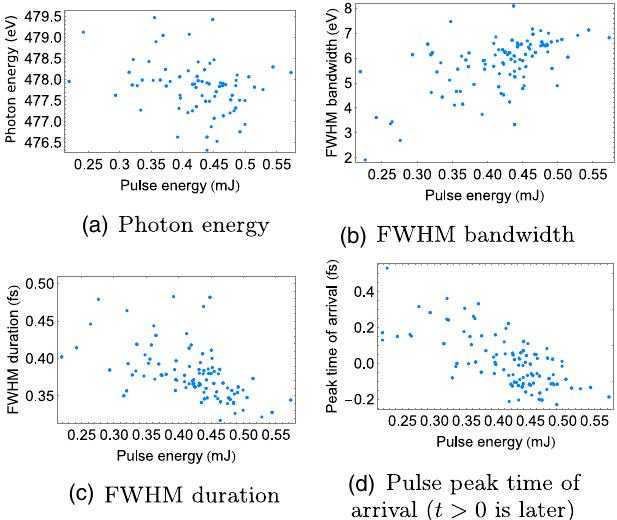
FIG. 4. Distributions of shot-to-shot variations of output pulse properties after all undulators for the third of four pulses in the pulse